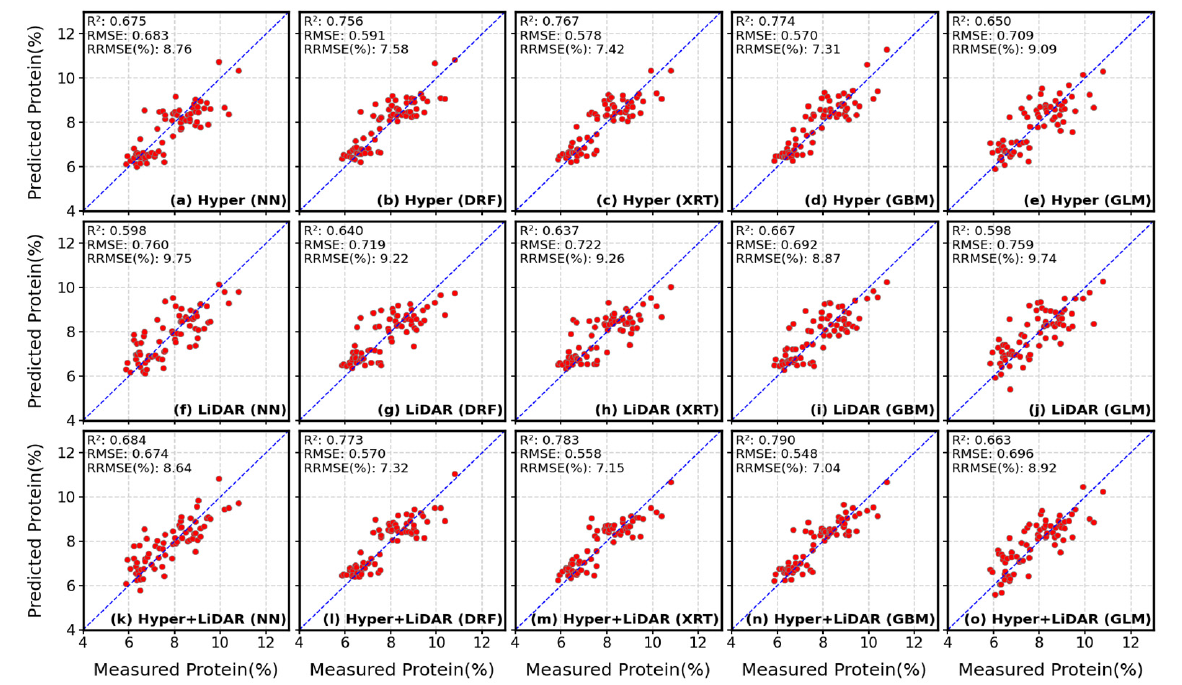
Figure 9. Scatter plots of measured vs. predicted corn protein concentration using different models with hyper-based, LiDAR-based and Hyper + LiDAR-based features.